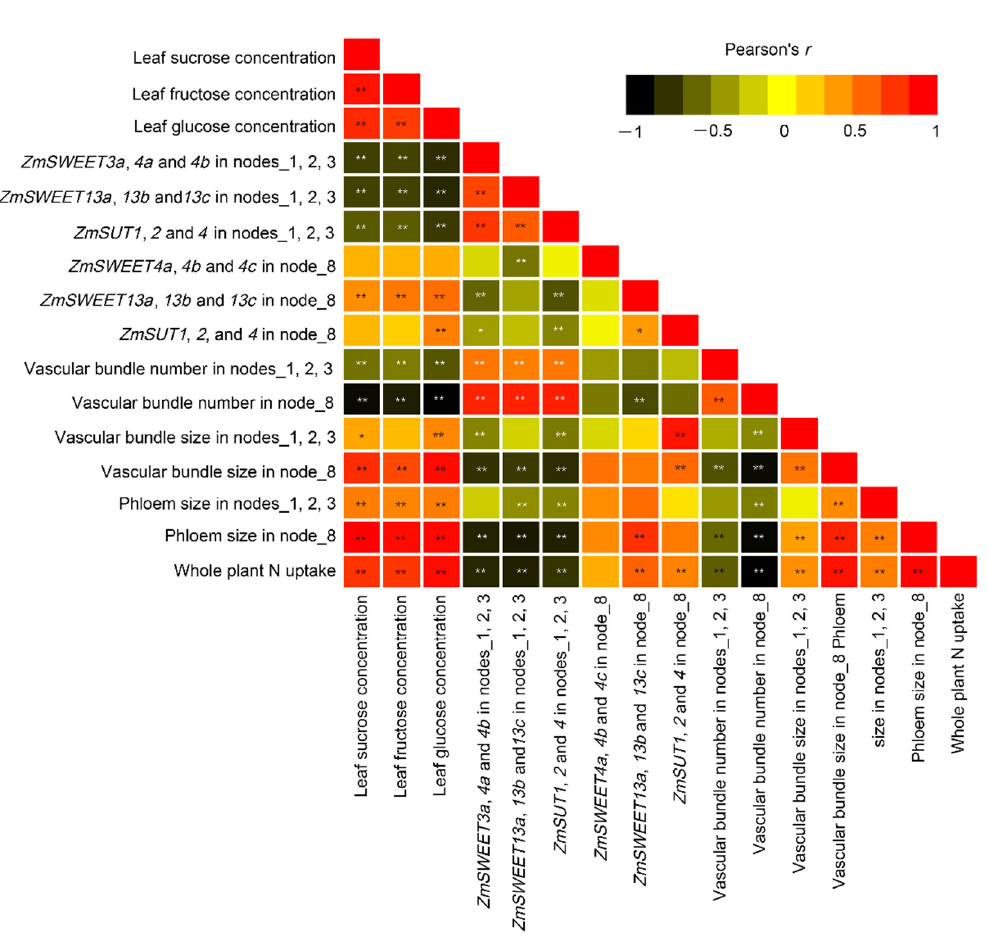
Figure 9. Correlation analysis of sugar concentrations, expression levels of sugar transporters, vascular bundle morphology, and total N uptake in maize plants. *, p < 0.05; **, p < 0.01.